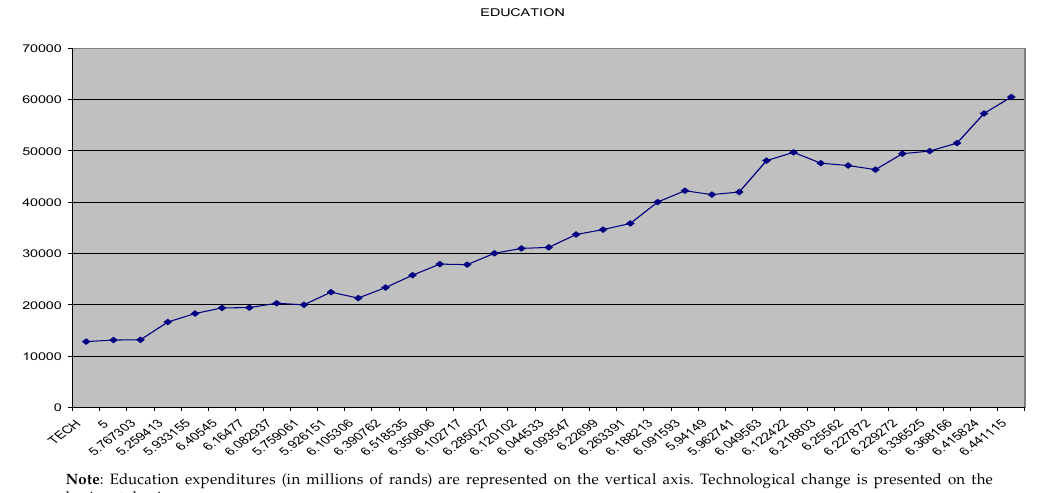
figure 2 Relationship between education expenditure and technological change (Source: Own construct)